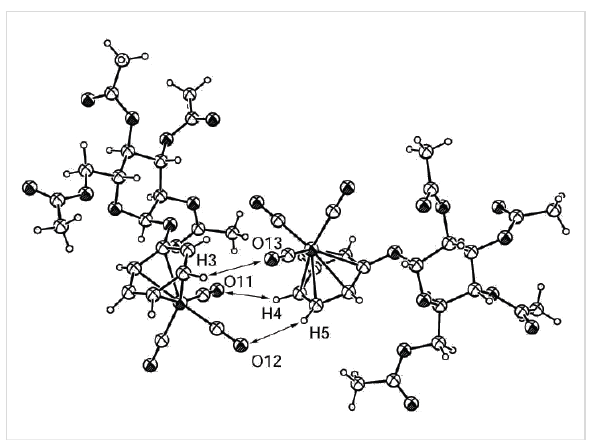
Figure 6: ORTEP-plot of the asymmetrical unit showing two mole- cules of compound 2e and 30% probability ellipsoids; the arrows show the nonclassical H-bonds between O13 and H3, O11 and H4 and O12 and H5.